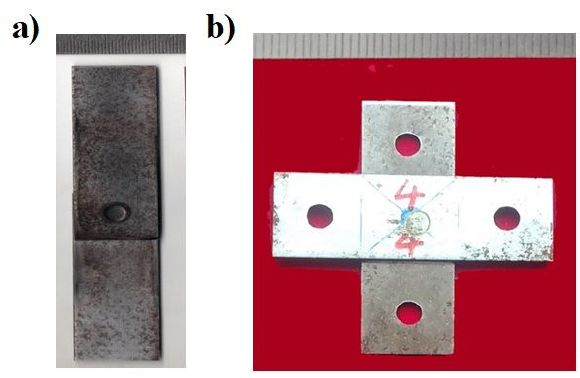
Figure 3: Photograph of typical TSFL specimens of RSW AHSS- DP800 joints: a) SL-TSFL; b)